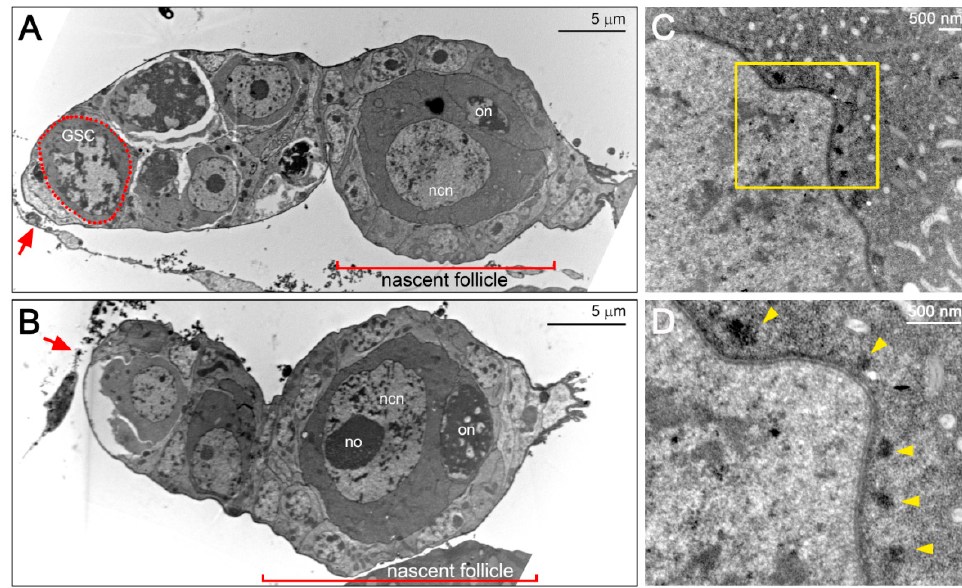
Figure 6. Transmission electron microscopy (TEM) examination of the germarium and the perinuclear nuage-like structure of the nurse cell. ( A , B ) TEM examination of germarium and nascent follicle. The germline stem cell (GSC) is marked by the dash-line. The oocyte is characterized by the condensed chromosomes at meiotic prophase. In nurse cell, the nucleus was featured by a large nucleolus and the patched chromatin. It is to be noted that the oocyte is moved from the lateral position ( A ) to the posterior end ( B ) of the nascent follicle. Red arrows indicate the ovarian sheath. ( C , D ) TEM examination of the perinuclear region in the nurse cell of a follicle at the previtellogenic stage. The electron-dense nuage-like structure is indicated by yellow arrowheads in ( D ). The region in the yellow rectangle of ( C ) is enlarged in ( D ). on: oocyte nucleus; ncn: nurse cell nucleus; no: nurse cell nucleolus. For all the panels, anterior is to the left.